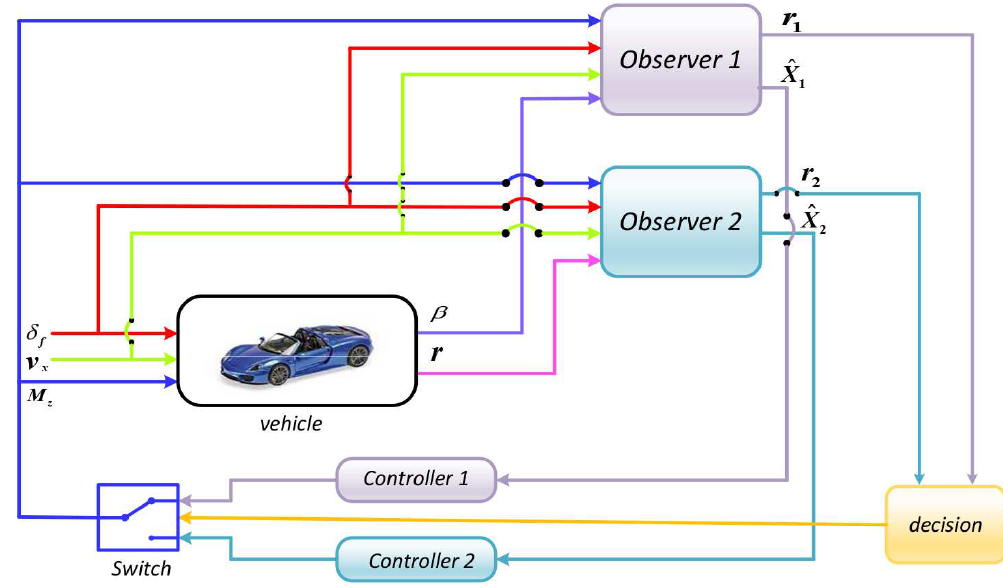
Figure 4. Structure of the vehicle FTC Strategy.